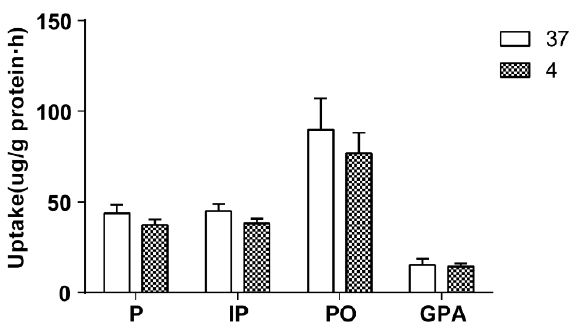
Figure 4. The uptake of the 4 component compounds at different temperatures.